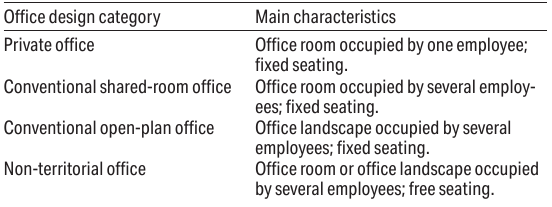
Table 1. Office design categories and definitions in the current